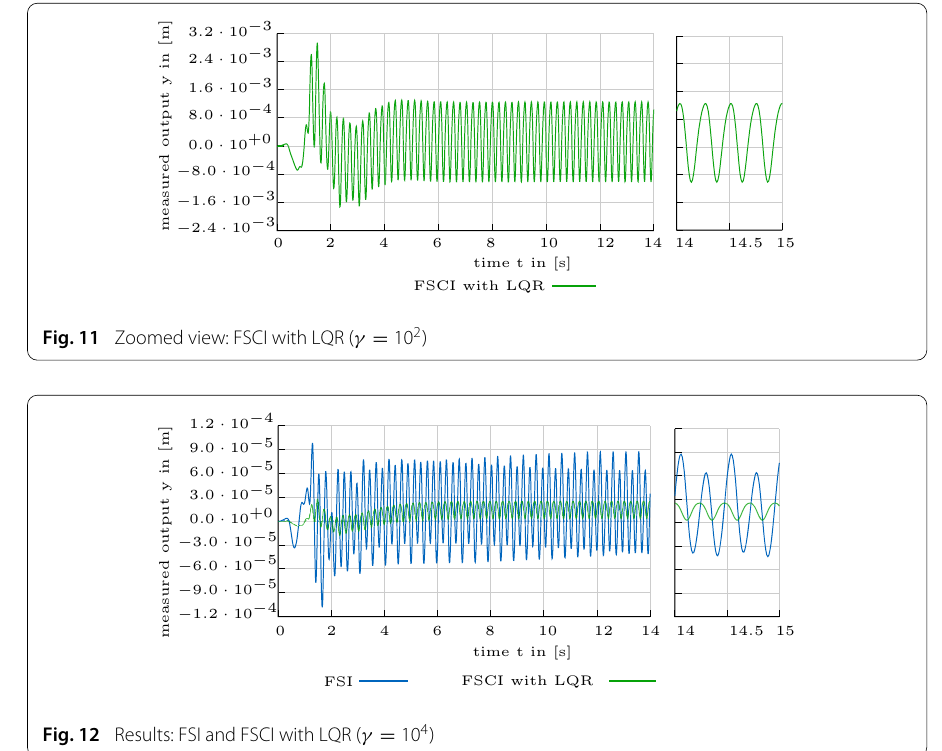
more into play and the system becomes softer. This means the eigenfrequencies of the fluid flow start to dominate the system behavior and the nonlinear behavior of the coupled system becomes stronger. It follows that a new controller design has to be conducted. For a value of γ ≤ 10 − 2 the structure is too soft and light to be able to control its behavior by a force applied at its rootpoint R . The results for such an example can be seen in Fig. 13. In Fig. 14 the overall number of interface iterations per time step for the different schemes applied to the numerical test example are plotted for the factor γ = 10 2 for the different coupling variants are plotted. For example in the case of F[SC]I, we count the number of interface iterations for the [SC] loop (inner loop) first and afterwards add the number of interface iterations between [SC] and F (outer loop). It can be seen that the FSCI scheme needs a similar number of iterations as the pure FSI. One reason for this can be for example seen in Table 2. For the FSCI problem the number of coupling loops is the same as for the pure FSI problem and thus also the total number of interface iterations is almost the equal. Looking closer at the number of interface iterations one can see, that the FSCI even needs less iterations at certain points than the pure FSI. This is, due to the fact that the controller stabilizes the system leading to a more homogeneous oscillation with a smaller amplitude. Using the F[SC]I scheme increases the number of iterations almost by a factor of three and using the [FS]CI by almost a factor of four. According to Table 2 an additional loop and also a higher numerical accuracy in the solvers of the subsystems is needed and the number of overall interface iterations increases. The reason that the F[SC]I requires fewer interface iterations than the [FS]CI version is the stabilizing behavior of the controller, which influences the outer FS loop in a positive way. Conversely, the contrary effect occurs for the [FS]CI